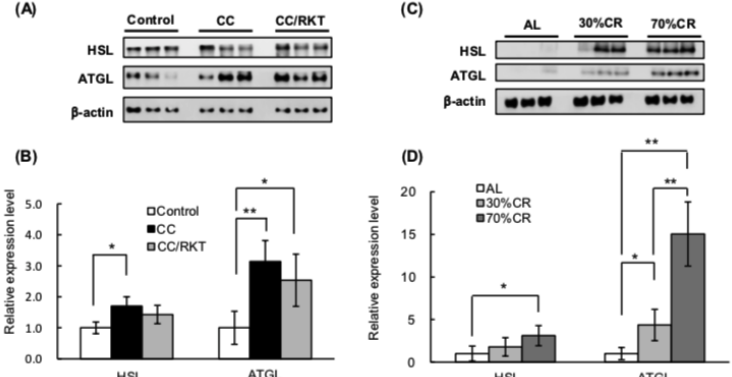
Figure 1. Effects of cancer cachexia (CC), rikkunshito (RKT) and caloric restriction (CR) on the histologic features of epididymal white adipose tissue (eWAT). Representative hematoxylin and eosin-stained histologic sections of eWAT from ( A ) control, CC, and CC/RKT rats and ( D ) rats fed ad libitum (AL) and subjected to CR (Magnification ×100, scale bar = 100 µm). Distribution of adipocyte size in ( B ) control, CC, and CC/RKT rats, and ( E ) AL and CR rats. The average of median adipocyte size in ( C ) control, CC, and CC/RKT rats, and ( F ) AL and CR rats. Error bars represent the SD associated with each mean ( n = 5 – 6); * p < 0.05, ** p < 0.01 by Tukey’s test.